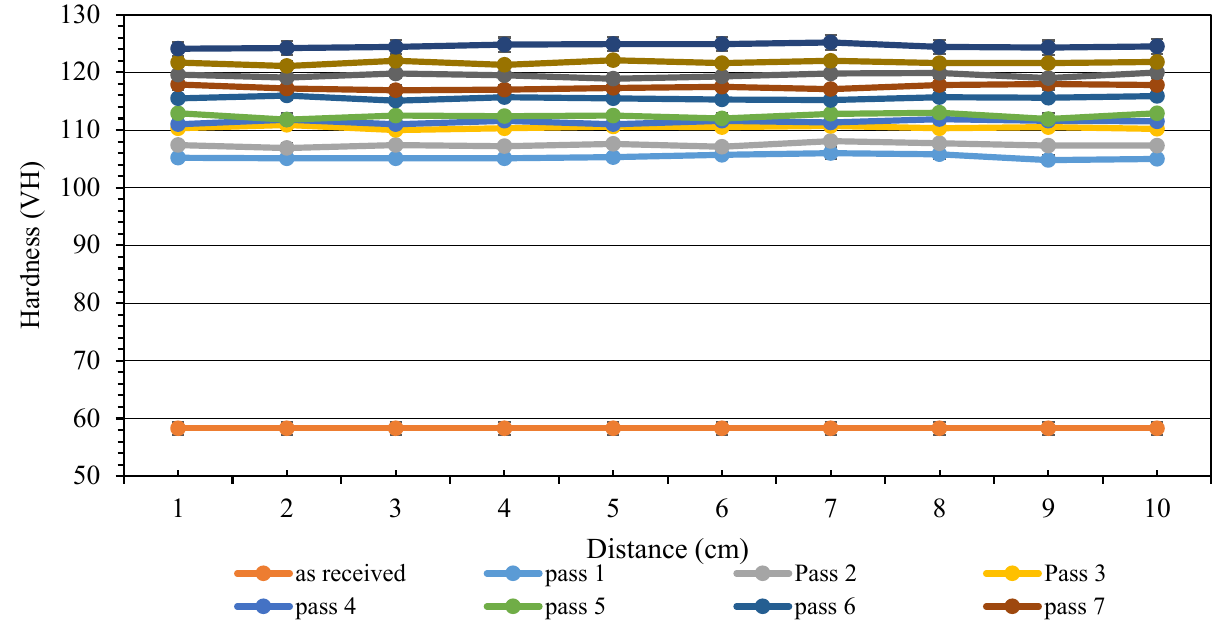
Figure 12. Direction of Vickers microhardness measurement with 10 points on the surface for the first pass of the modified-CSP sample.